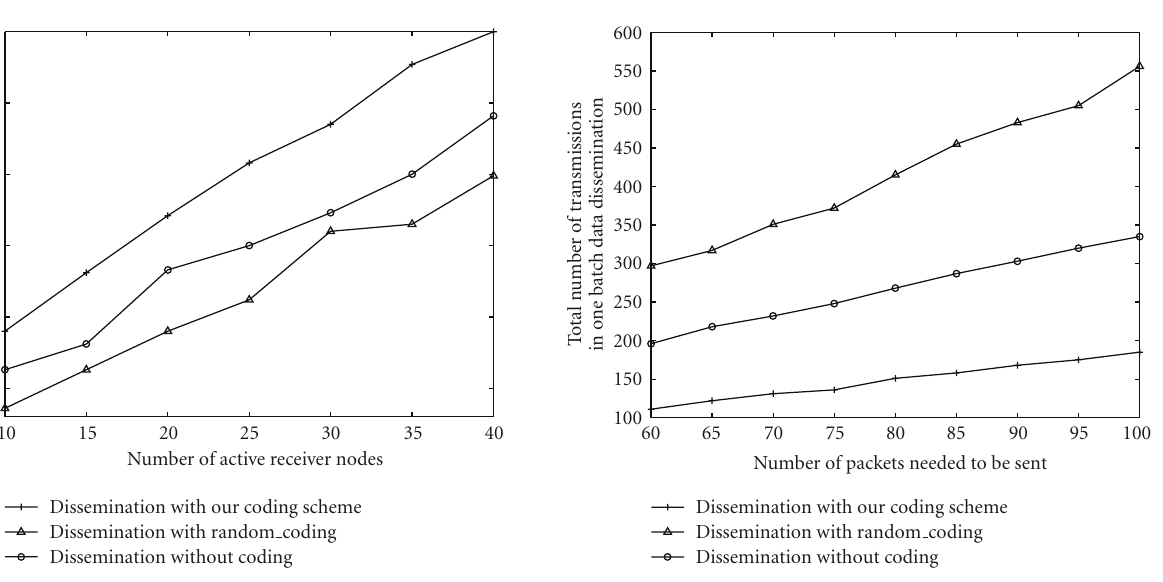
Figure 4: The number of receivers that can obtain a new “wanted” packet at a time slot versus the number of receiver nodes.